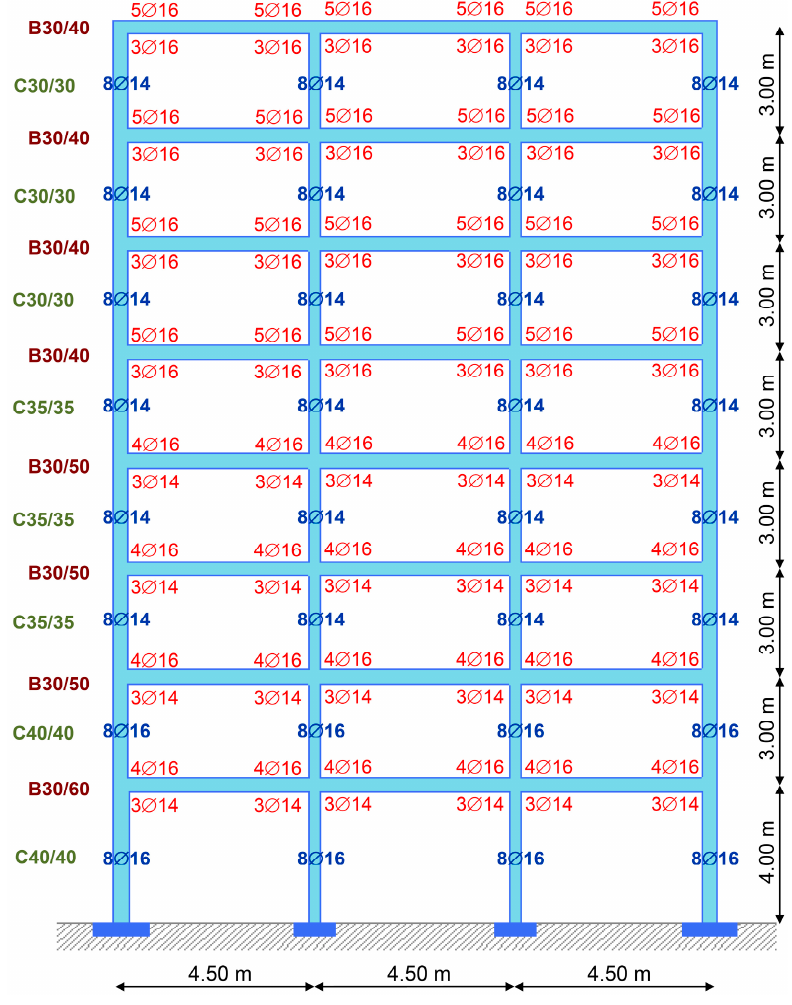
Figure 7. Frame B3 properties.